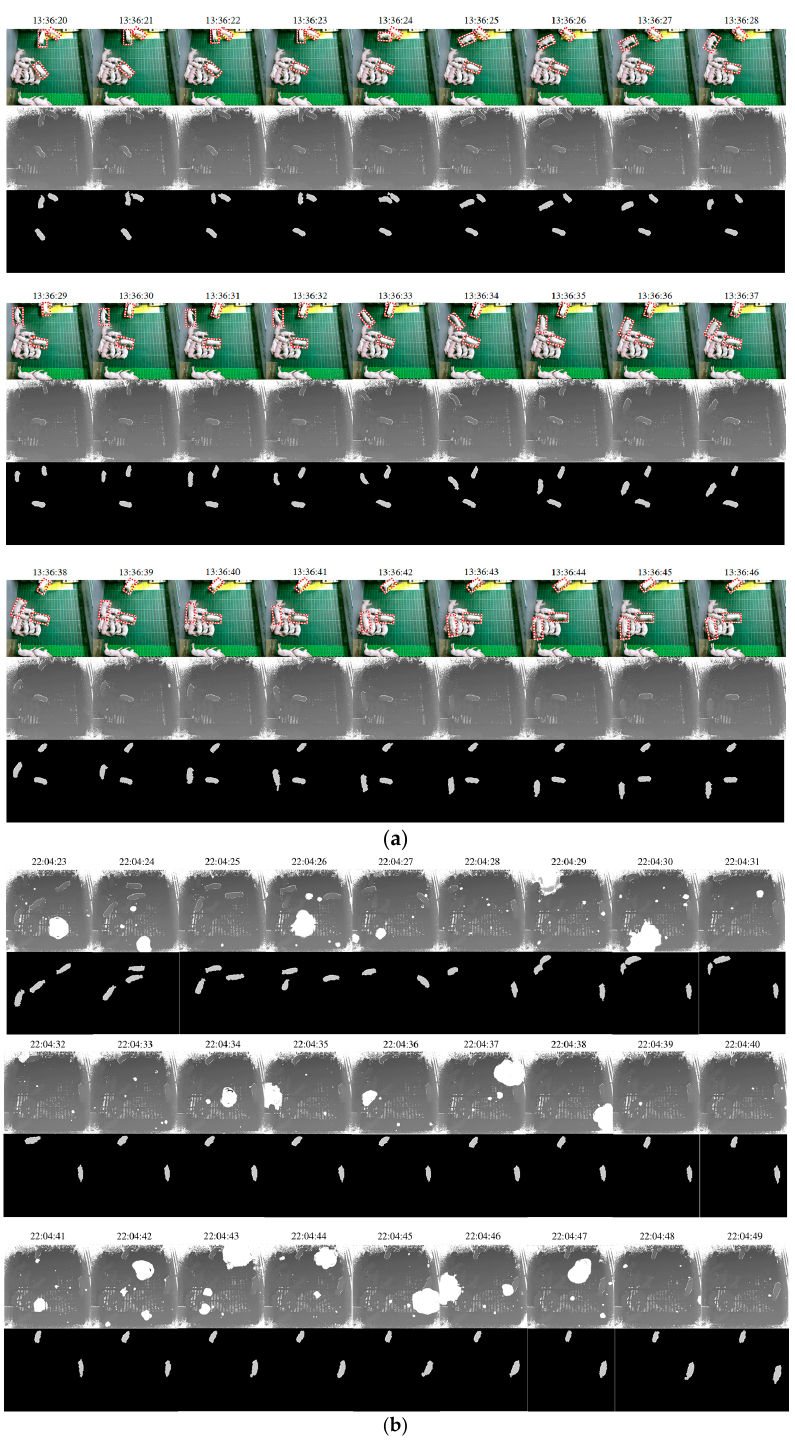
Figure 13. Results of detection of standing-pigs during the daytime and nighttime: ( a ) detected standing-pigs during daytime (13:36:20–13:36:46); and ( b ) detected standing-pigs during nighttime (22:04:23–22:04:49). Because a light was turned off, corresponding color images are not shown during nighttime.